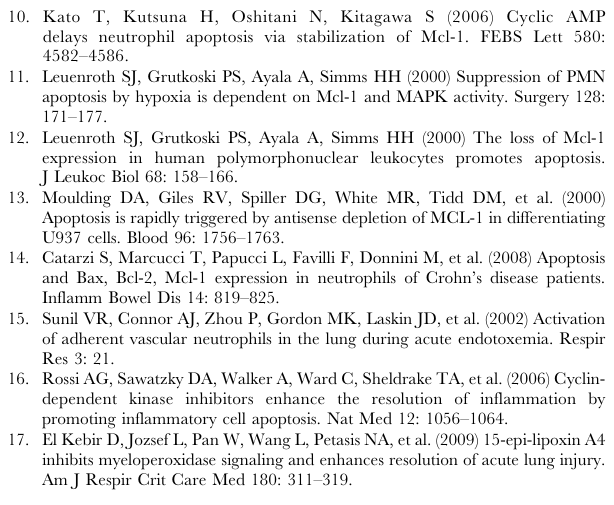
Figure S1 Mcl-1 levels fall between 0 and 8 hours in culture and GM-CSF prevents this reduction. A . Neutro- phils were either lysed at time 0 or cultured 6 GM-CSF for 8 hours and relative Mcl-1 levels determined using western blotting. Mcl-1 levels fall significantly between time 0 and time 8 lysates (*p , 0.001 for control vs 8 hours - GMCSF, one way ANOVA with Bonferroni’s post-test correction, n= 2.). GM-CSF treatment maintains Mcl-1